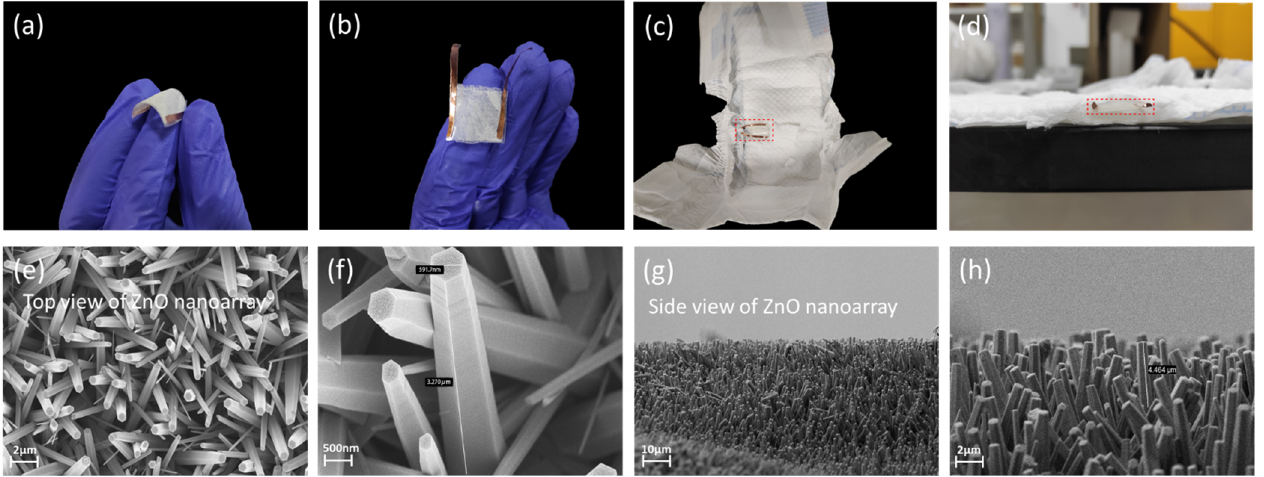
Figure 2. Morphology and microstructure of the self-powered wearable biosensor in baby diaper. ( a ) Side view of the flexible device. ( b ) Top view of the device. ( c , d ) The device embedded in baby diaper. ( e – h ) SEM images of ZnO nanoarray.